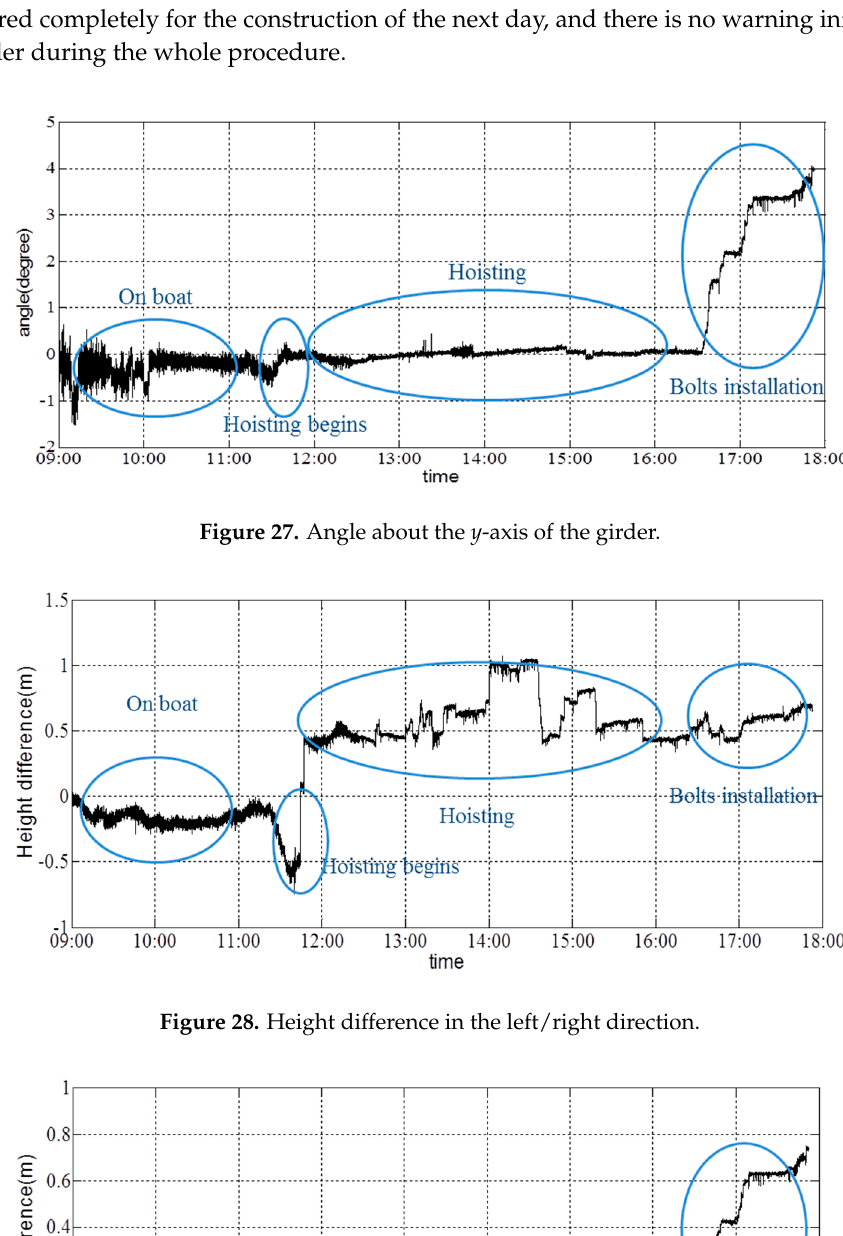
Figure 26. Angle about the x -axis of the girder.